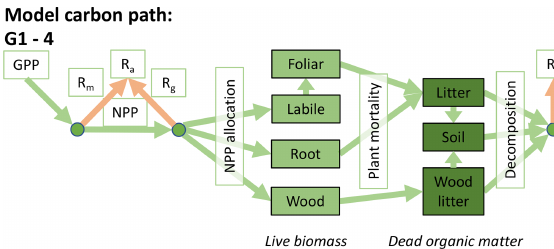
Figure B3. Carbon cycle structure for models G1–G4.